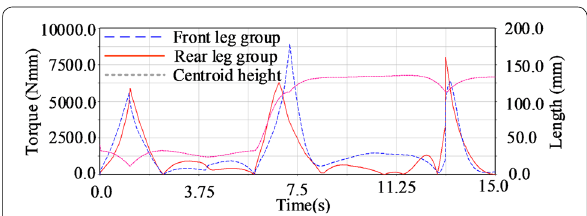
Figure 13 Motor torque and centroid height